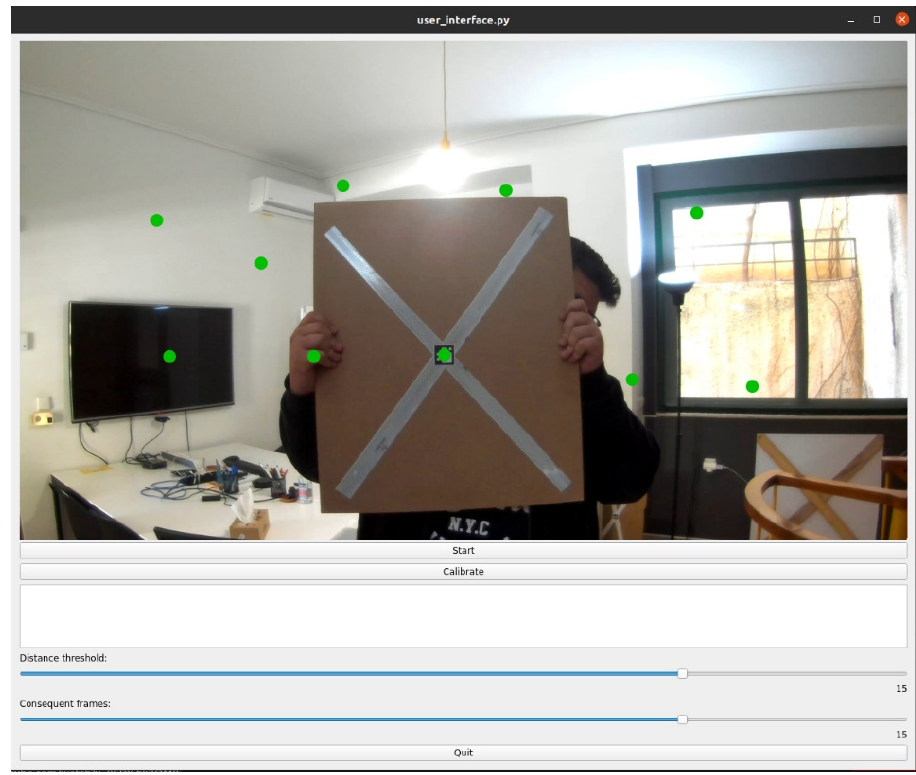
Figure 5. The graphical user interface of the proposed calibration application displaying the feed from the camera and two sliders for setting the parameters “distance threshold” and “consequent frames”. The image displays the positions of the current and previously accepted measurements.